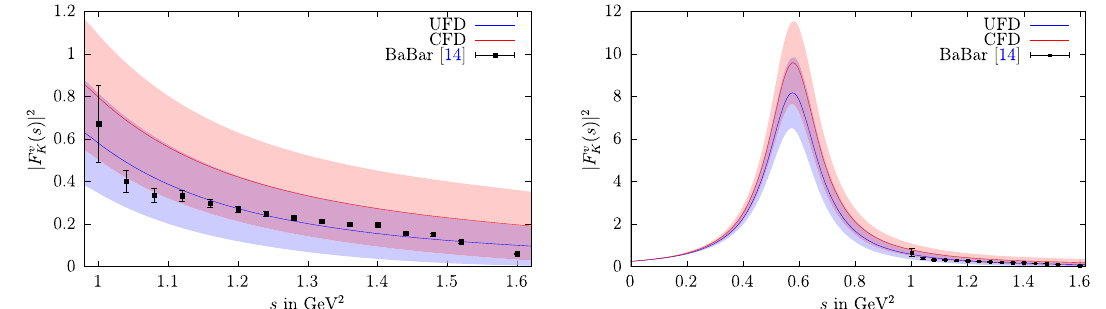
Fig. 1 The kaon isovector form factor with input from the UFD (blue) and CFD (red) parameterizations from Ref. [40], compared to the BaBar data [14] for the τ − → K − K S ν τ decay (left) and in the full kinematic range including the ρ resonance